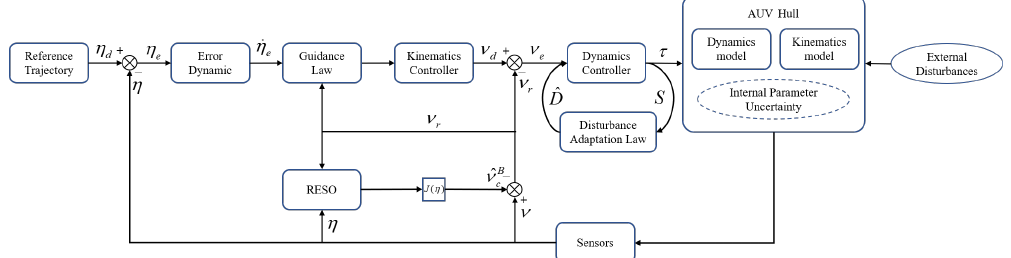
Figure 2. The frame of trajectory tracking